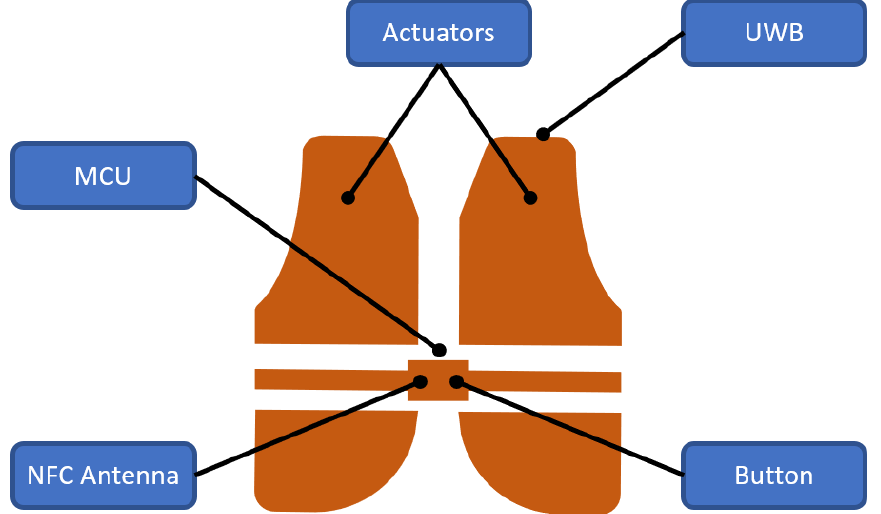
Figure 4. Placement of the smart lifejacket components.